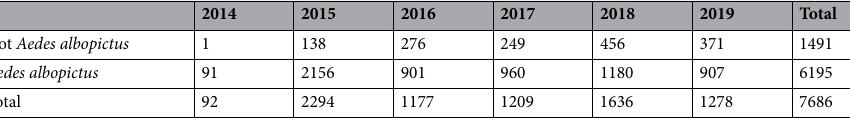
Table 1. The collected and expert validated dataset for the period 2014–2019. Ae. albopictus are clearly over- represented, which is expected because the system targeted only this species until 2016, and two species Ae. albopictus and Ae. aegypti from 2016 to